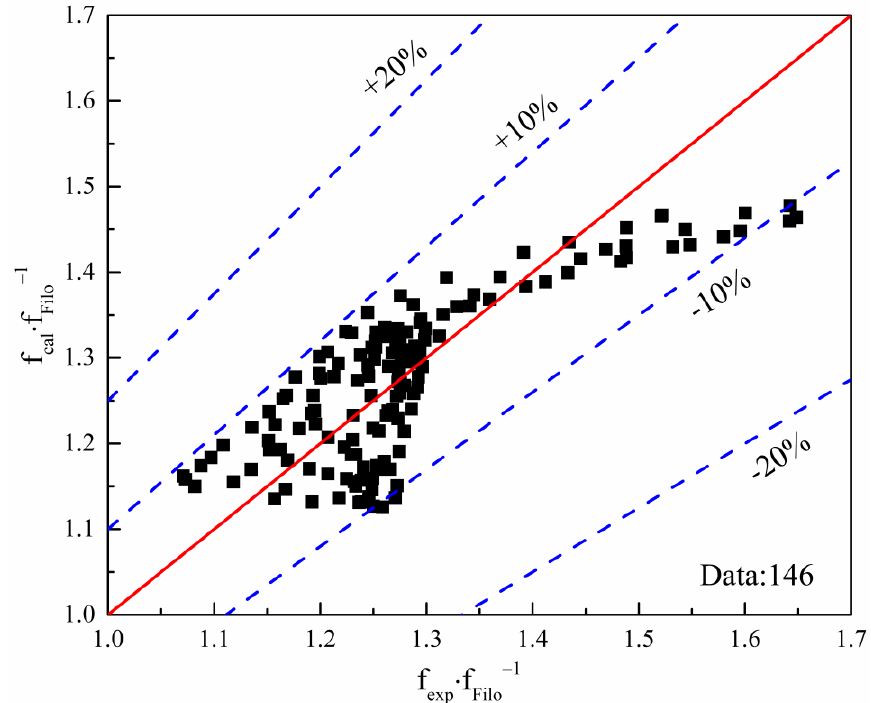
Figure 12. Comparison of the experimental friction factor with the new correlation of Equation (5). f cal : the calculated friction factor of Equation (5), f exp : the experimental friction factor, f Filo : the calculated friction factor of Filonenko correlation